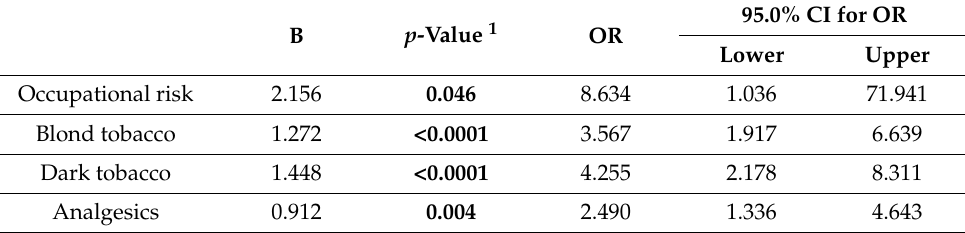
Table 5. Independent predictive factors of bladder cancer. Conditional logistic regression model.